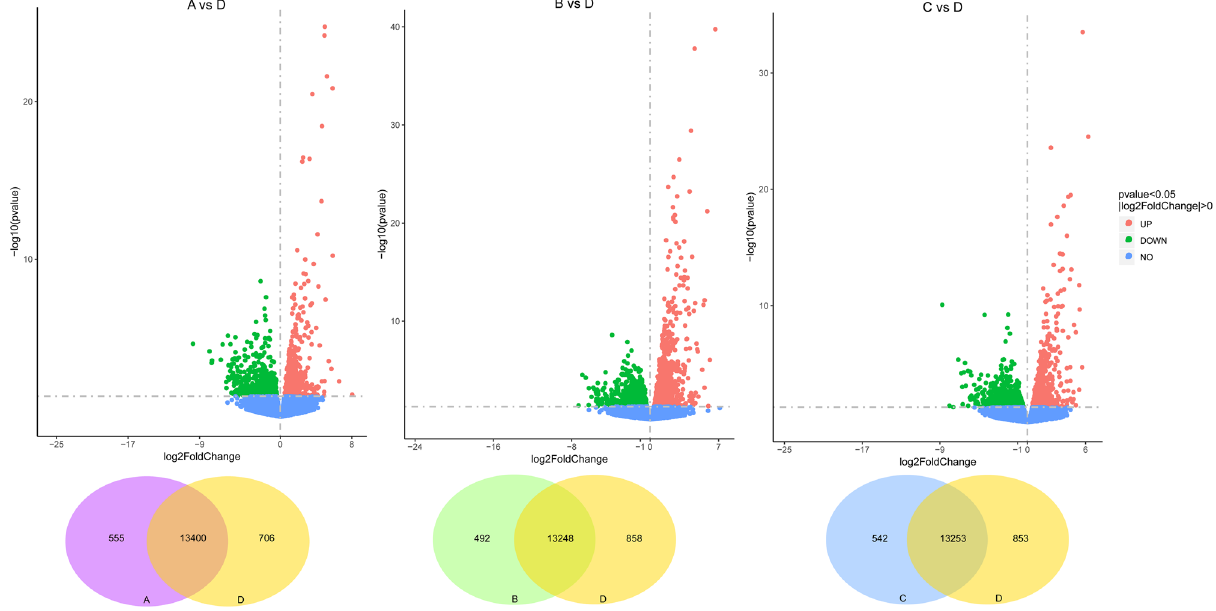
Figure 6. Scatter diagrams exhibiting differentially expressed gene profiling comparisons between group D and other three Bti exposed groups. A, Group A vs Group D; B, Group B vs Group D; C, Group C vs Group D. Blue point, non-significant difference in gene; red point: up-regulated gene; green point: down-regulated